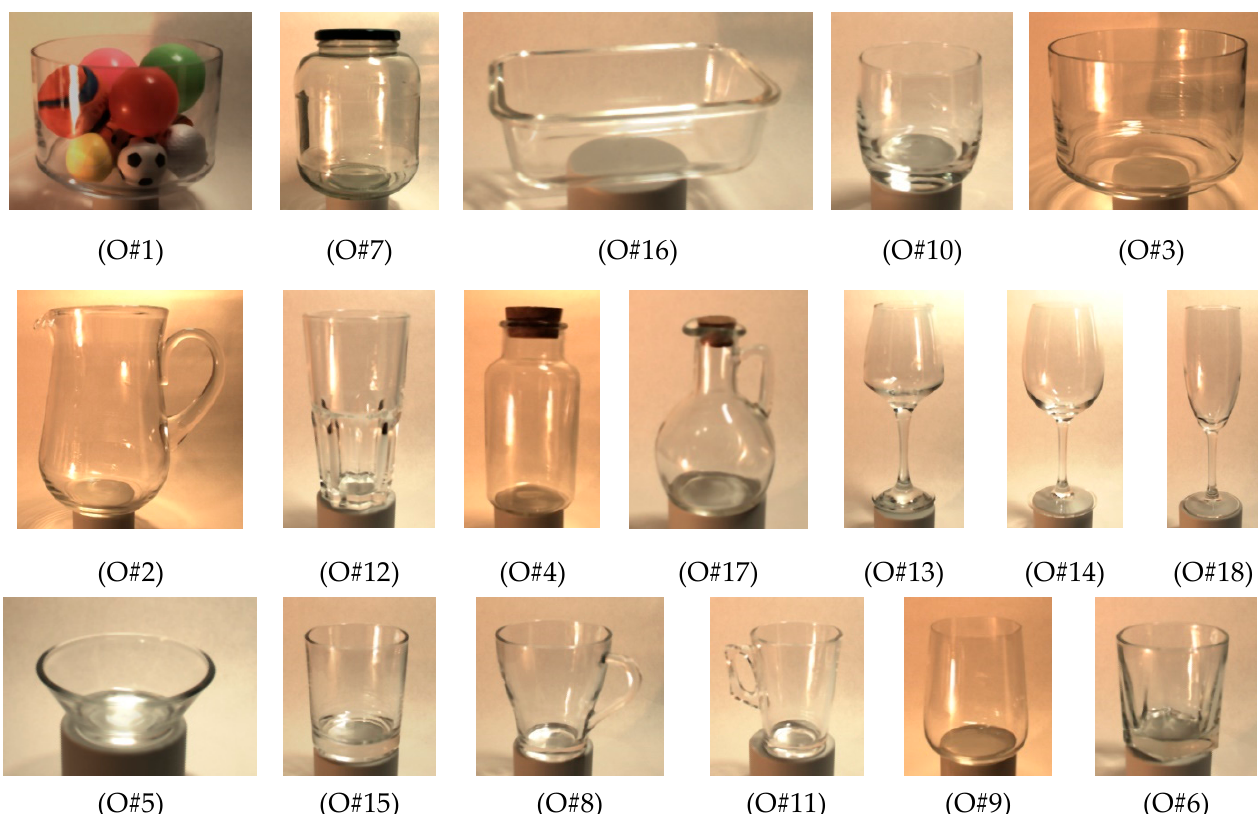
Figure 2. Median specular reflections of MSPLFI for different objects: (O#1) round container with ball; (O#2) classic jug; (O#3) empty round container; (O#4) jar with cork lid; (O#5) sauce container; (O#6) ice glass; (O#7) clear glass jar; (O#8) coffee cup; (O#9) cuvee tumbler; (O#10) glass tumbler; (O#11) teacup; (O#12) water glass; (O#13) Bordeaux wine glass; (O#14) red wine glass; (O#15) hi-ball glass; (O#16) food box; (O#17) jar with cork handle; (O#18) port wine glass.